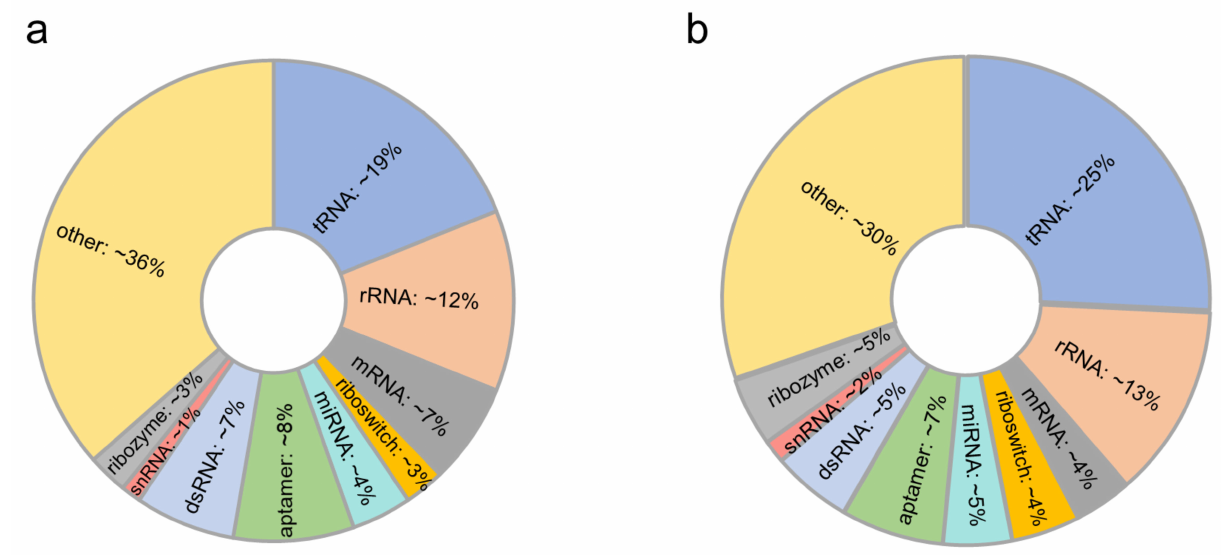
Figure 1. ( a , b ) the proportion of various types of RNA and the pocket distribution of each RNA type in our